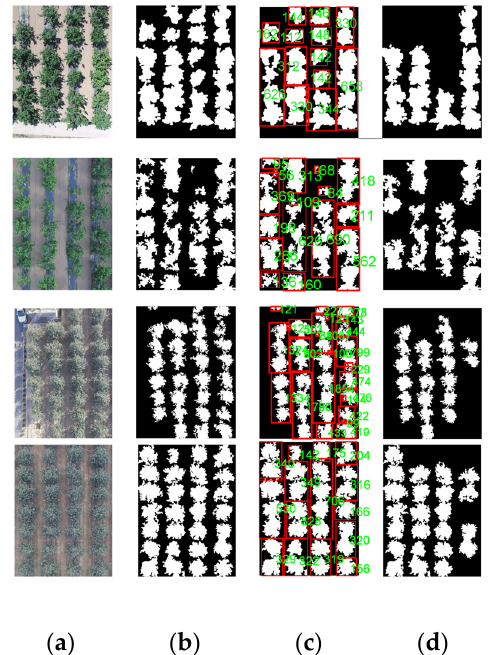
Figure 4. Extraction process of interlacing canopy region: ( a ) original image; ( b ) background removal; ( c ) intermingling canopy identification; ( d ) intermingling canopy extraction.